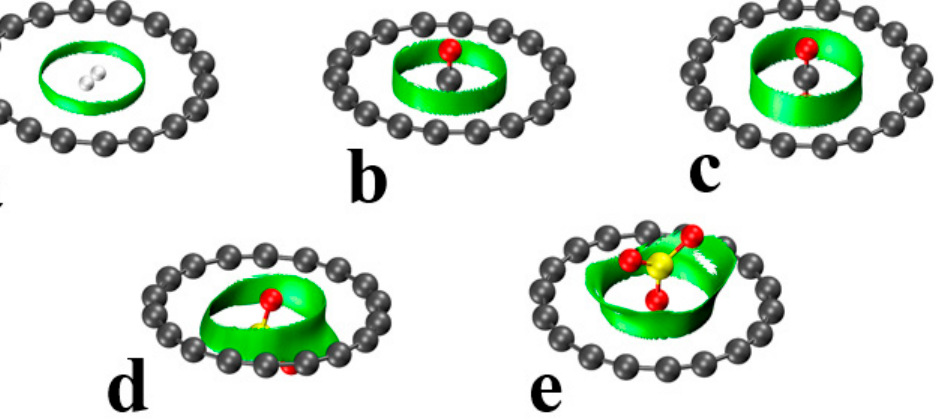
Figure 2. NCI isosurfaces of the C 18 –L (L = ( a ) H 2 , ( b ) CO, ( c ) CO 2 , ( d ) SO 2 , ( e ) SO 3 ) dimers (green spheres represent noncovalent interaction regions) at the RDG 0.5 au isovalue.